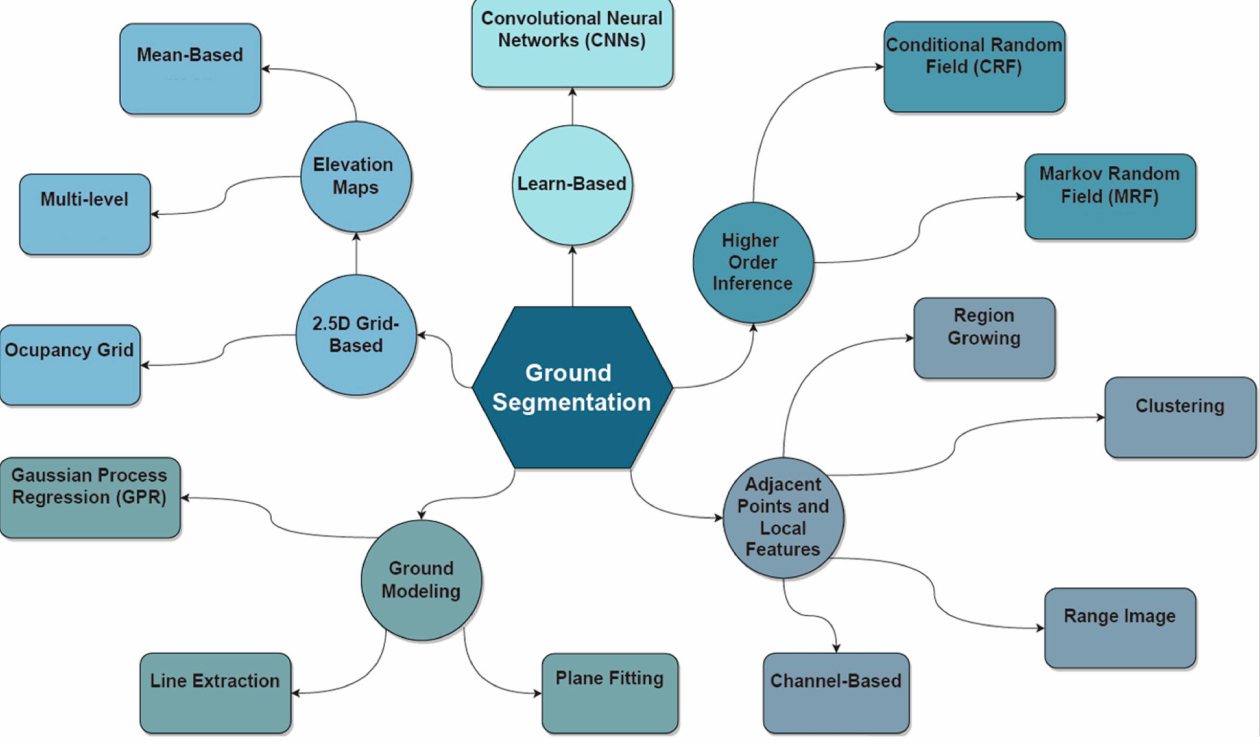
Figure 5. Classification and taxonomy of existing ground segmentation